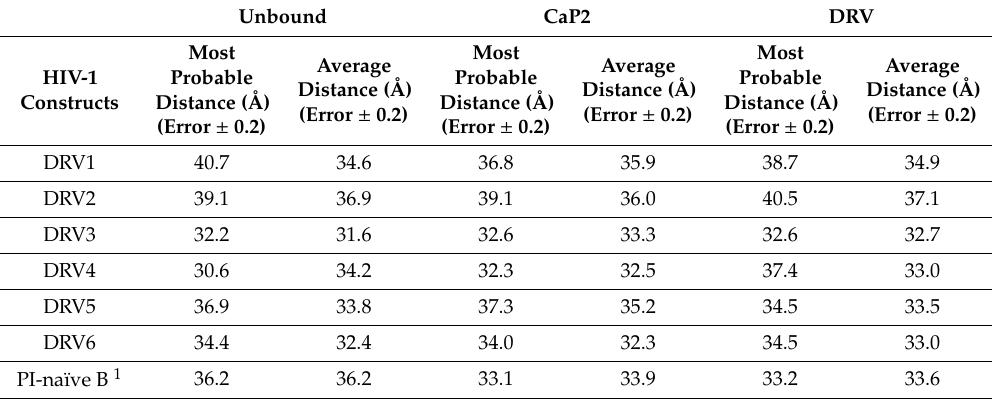
Table 1. DEER distance profiles for HIV-1 DRV-resistant proteases and PI-naïve subtype B.